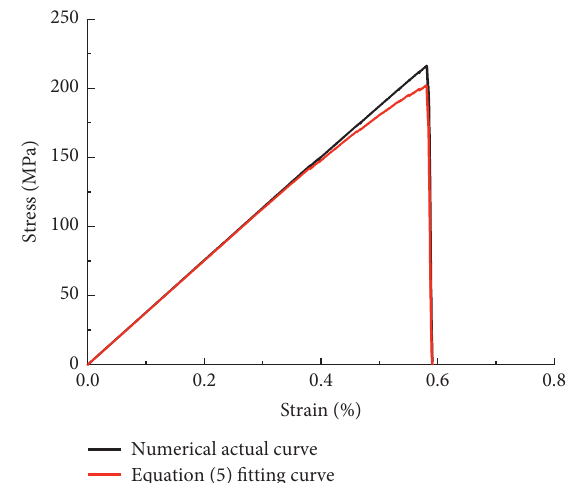
Figure 9: Fitting stress-strain curve of standard size rock.